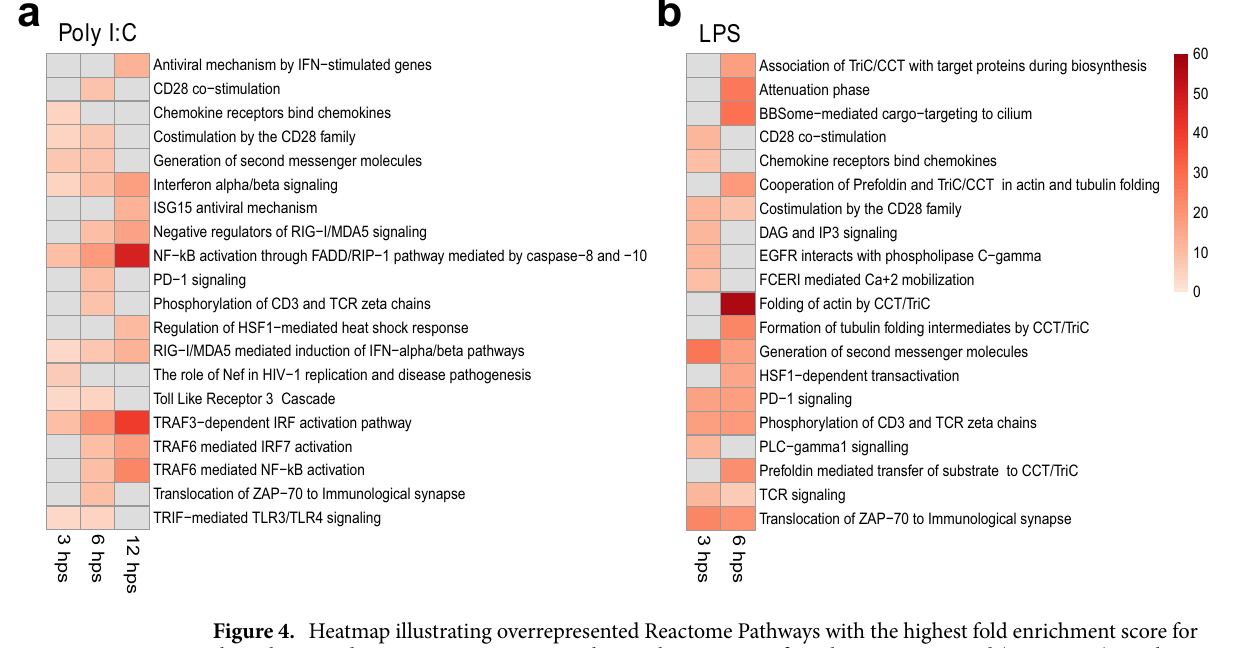
Figure 4. Heatmap illustrating overrepresented Reactome Pathways with the highest fold enrichment score for the poly I:C and LPS treatment groups. Pathways that were significantly overrepresented (FDR < 0.05) are shown in red colour, with faint red indicating lower fold enrichment score and dark red a higher fold enrichment score. Pathways that were not significantly overrepresented are shown in grey for that particular treatment group and time point. No Reactome Pathways were overrepresented in the S. aureus treatment group, nor 24 hps in the poly I:C treatment group or 12/24 hps in the LPS treatment group. All overrepresented gene ontology terms are listed in Supplementary Datasets S5–S6.